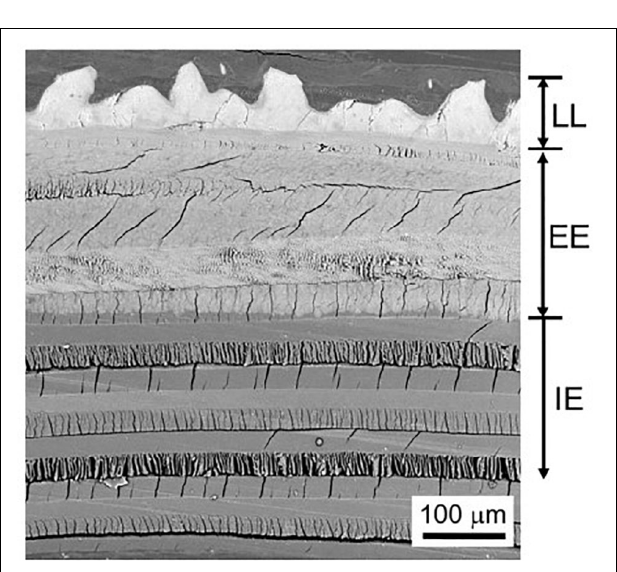
FIGURE 5 | SEM cross-section image of an elasmoid fish scale (tarpon) (Arola et al.,